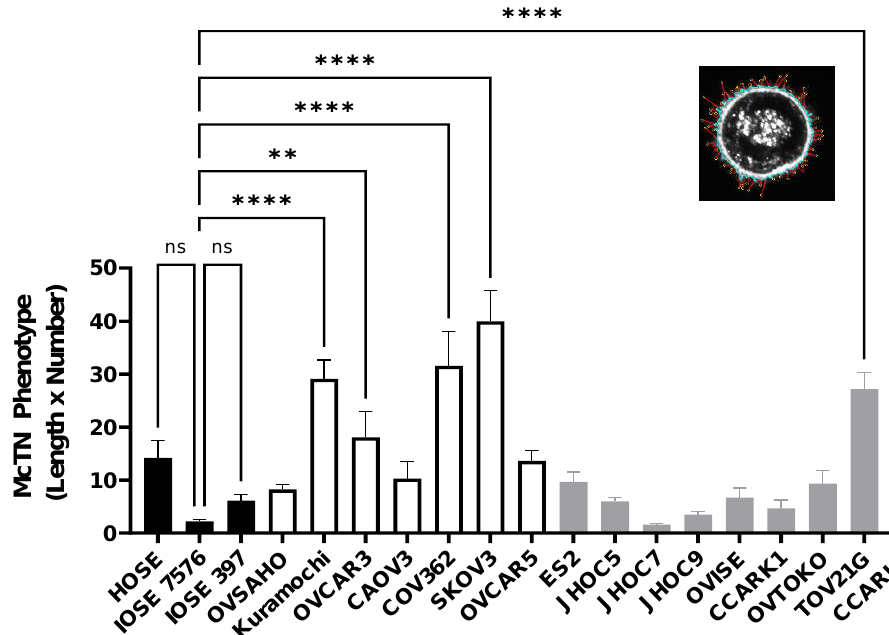
Figure 2. McTN phenotypes quantified by MATLAB can be described by the product of the average length of the McTNs (inset, yellow tip to blue body) by the number of McTNs per cell. Results are shown for human/immortalized ovarian surface epithelium (HOSE/IOSE) (black bars), ovarian clear cell carcinoma (OCCC) (grey bars), and ovarian serous carcinoma (OSC) (white bars) cell lines ( n ≥ 1 9, 19–27, mean and standard error of the mean.) OSC and OCCC McTN length × number were compared to HOSE/IOSE McTN length × number by one-way ANOVA with a Dunnett Post Hoc Analysis with an alpha set to 0.5. ** p < 0.002; **** p < 0.0001, ns –